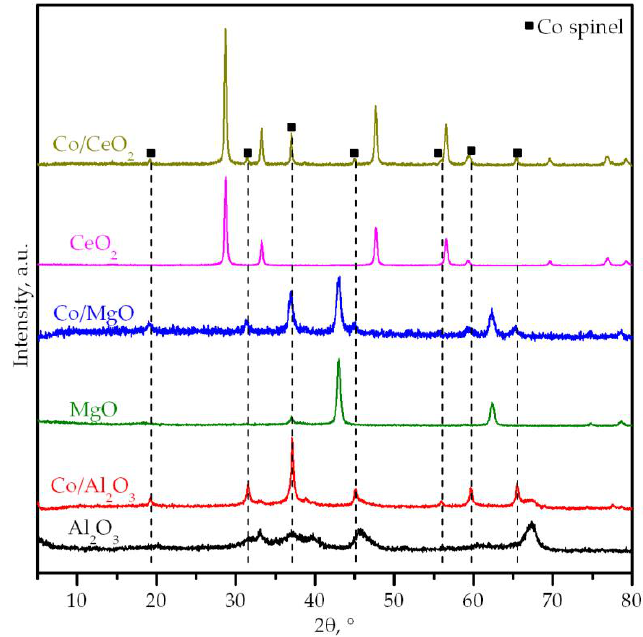
Figure 1. XRD patterns of the bare supports and the supported cobalt catalysts.